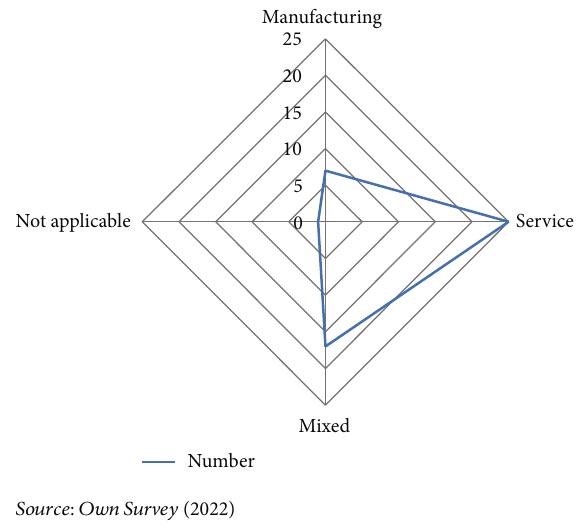
Figure 4: Online consumer behavior studies by